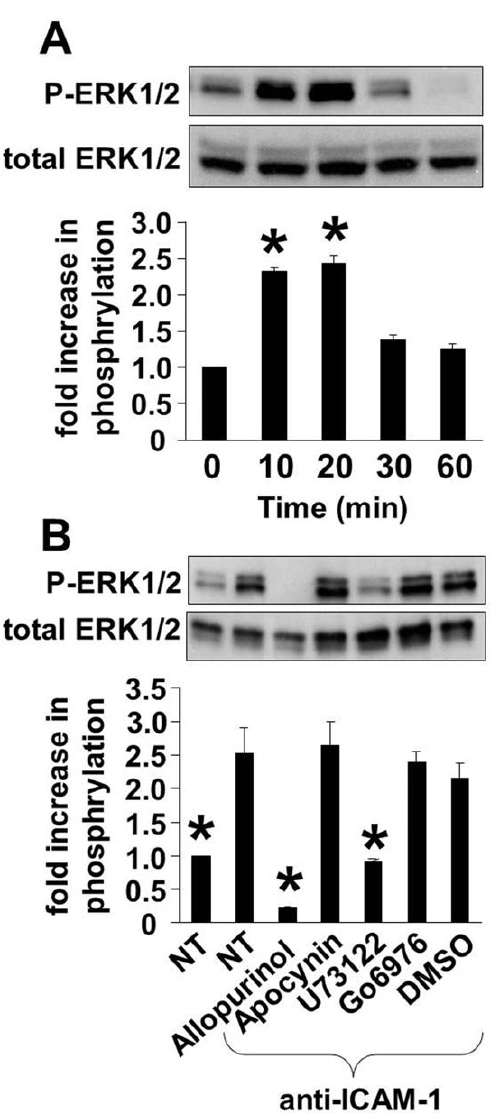
Figure 3. ICAM-1 activation of PKC a phosphorylation in HMVECLs is mediated by xanthine oxidase stimulation of ERK1/2. 70% confluent monolayers of HMVECLs were pretreated with TNF a to induce ICAM-1 expression. A ) Time course for anti-ICAM-1- coated bead stimulation of ERK1/2 Thr 202 /Tyr 204 phosphorylation (P- ERK1/2). *, p , 0.05 as compared to the nontreated control group. B ) TNF a -pretreated HMVECLs were incubated for 1 hr with the pharma- cological inhibitors allopurinol (0.3 mg/ml), U73122 (10 m M), and Go6976 (2.3 nM), apocynin (4 mM), or the solvent control DMSO (0.01%). The cells were nonstimulated (NS) or stimulated with anti- ICAM-1-coated beads and examined by western blot for ERK1/2 Thr 202 / Tyr 204 phosphorylation and total ERK1/2. Shown are the means 6 SEM from 3 experiments. Panel A: *, p , 0.05 as compared to 0 minutes. Panel B: *, p , 0.05 as compared to the anti-ICAM-1-stimulated group.